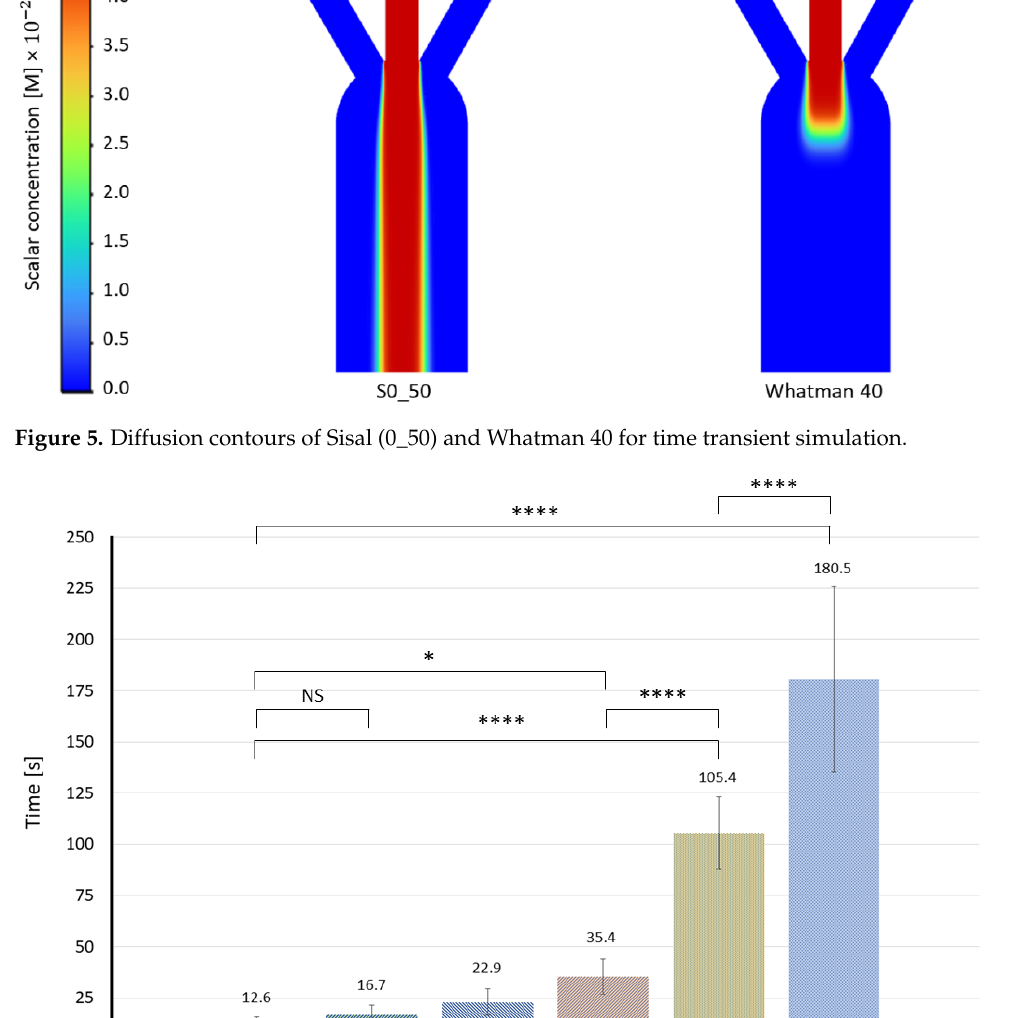
Figure 5. Diffusion contours of Sisal (0_50) and Whatman 40 for time transient simulation.